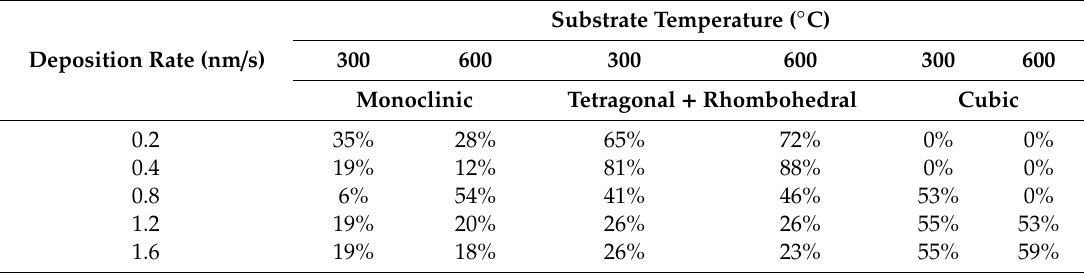
Deposition Rate (nm/s) Table 2. The ratio of cubic, tetragonal and monoclinic phases in the ScAlSZ thin films.